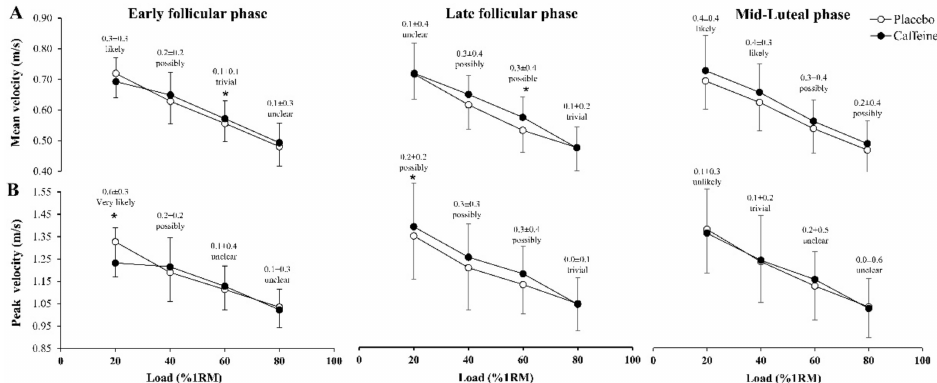
Figure 2. Changes induced with the ingestion of 3 mg / kg / bm of ca ff eine on mean velocity ( A ) and peak velocity ( B ) during the concentric phase of the Smith machine half-squat exercise of increasing loads (20%, 40%, 60% and 80% of one repetition maximum; 1RM) in each phase of the menstrual cycle. Data are mean ± standard deviation from 13 eumenorrheic athletes. The information over the data corresponds to the ca ff eine-placebo e ff ect size statistic ± 90% confidence intervals and magnitude base inference of this comparison. (*) Ca ff eine di ff erent from placebo within the same menstrual cycle phase at P <